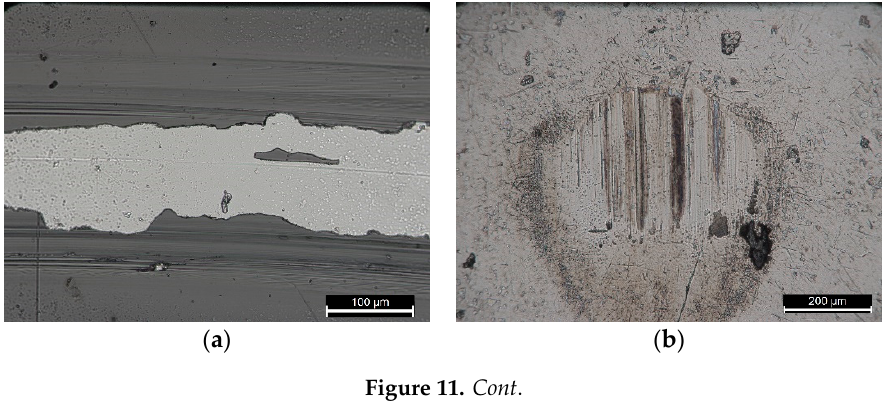
Figure 10. Tribological properties of selected coatings: ( a ) friction coefficient; ( b ) specific wear rate of the coated disks; ( c ) specific wear rate of the